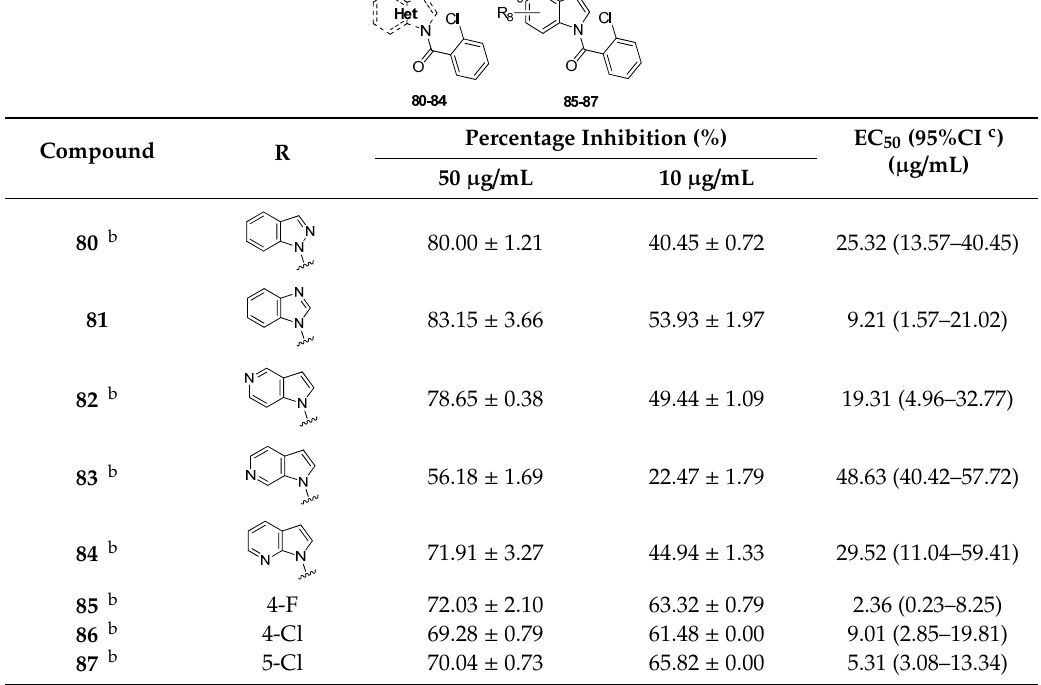
Table 4. In vitro fungicidal activity of compounds 80–87 . a